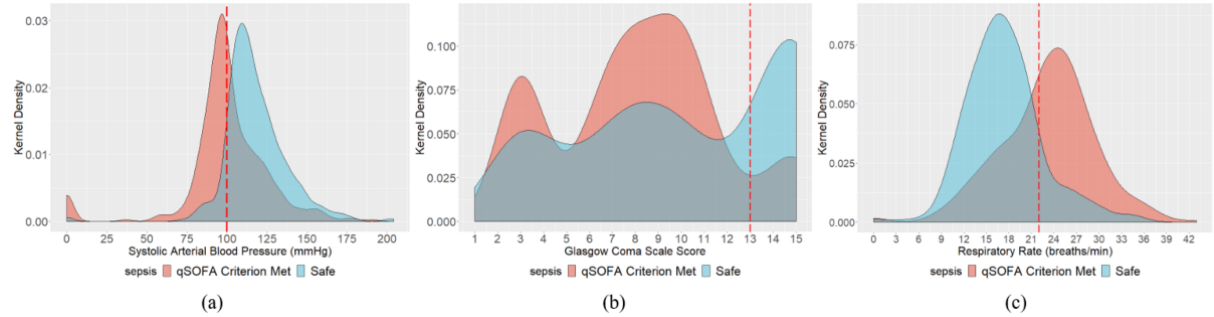
Figure 7. Kernel density estimation distribution of quick Sequential Organ Failure Assessment (qSOFA) parameters for both safe and qSOFA criterion–met patients at first observations to identify the prevalent qSOFA parameters.